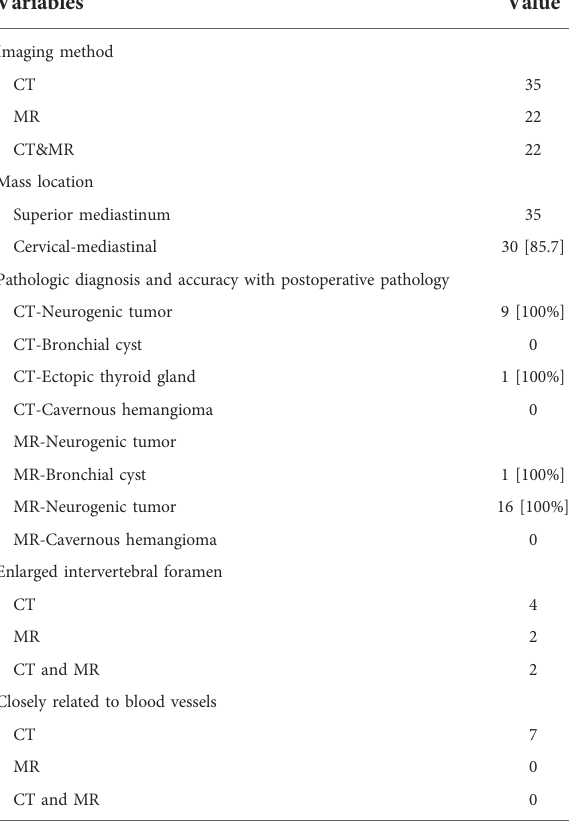
TABLE 2 Preoperative imaging characteristics.